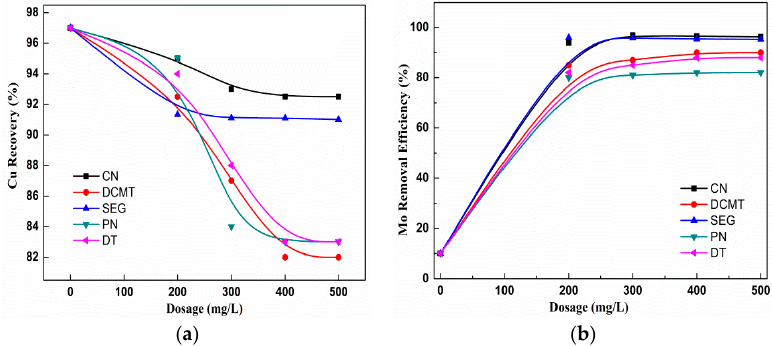
Figure 6. ( a ) Cu recovery versus ( b ) Mo removal efficiency using different depressants (CN: sodium cyanide, DCMT: disodium carboxymethyl trithiocarbonate, PN: P-Nokes reagent, DT: the main ingredient is sodium hypochlorite, SEG: seaweed glue).